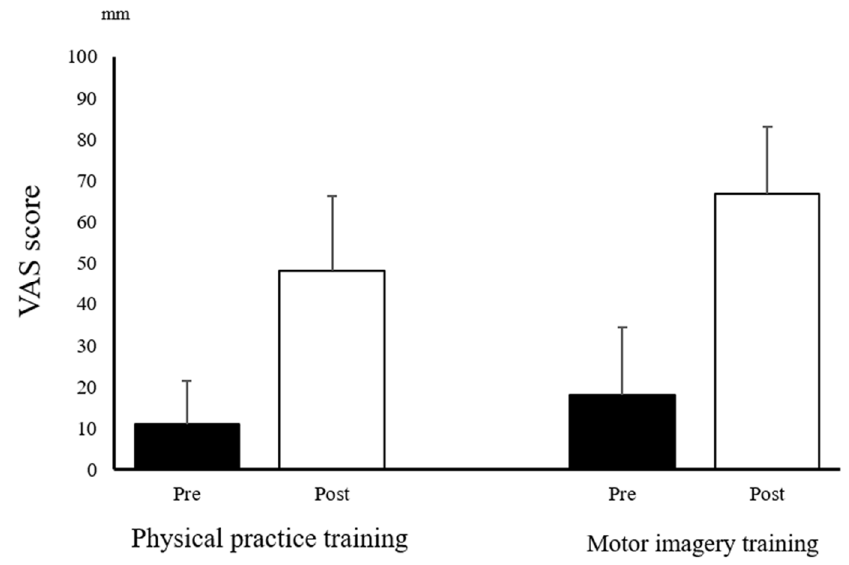
Figure 3. VAS before and after training. VAS, visual analog scale.